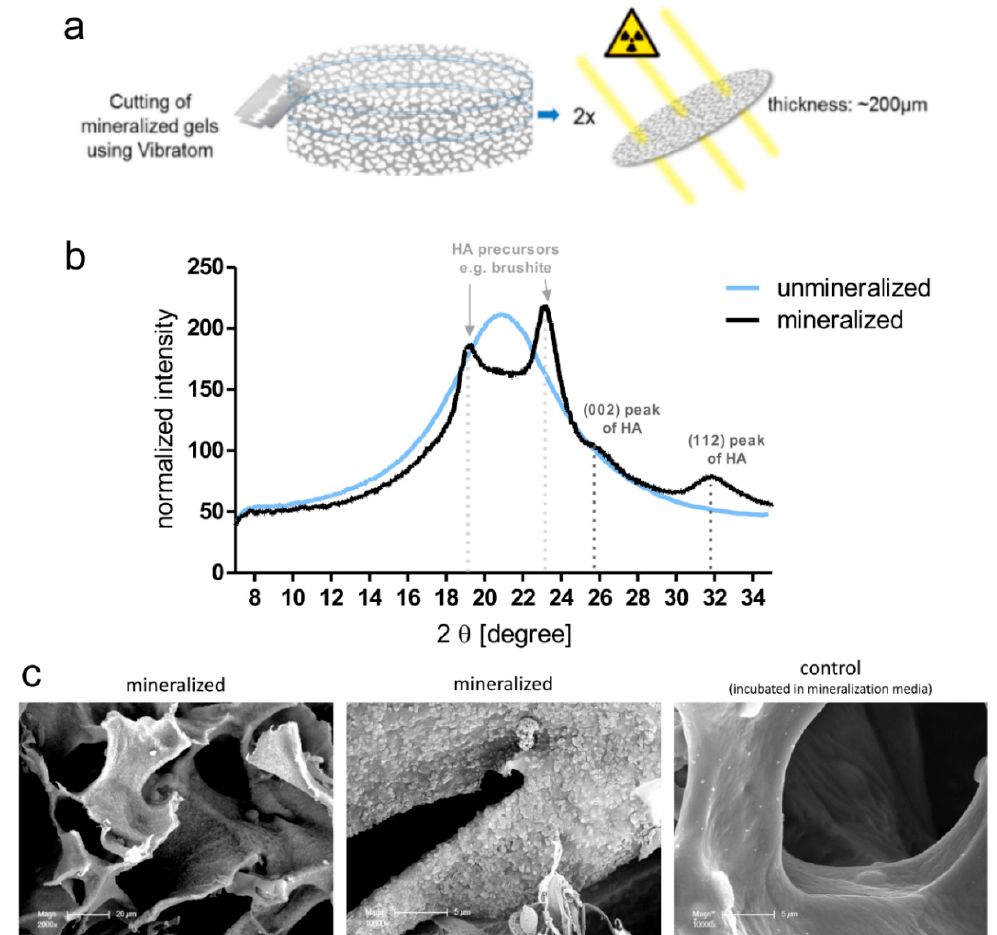
Figure 2. Wide-Angle X-ray Scattering (WAXS) diffraction pattern and scanning electron microscopy (SEM) of mineralized in comparison to nonmineralized cryogels. ( a ) Two different cryogel scaffolds were analyzed. Each cryogel scaffold was cut into thin slices (400 µ m swollen state/200 µ m dry state) using a vibratome. Afterwards the cut gel discs were dried and then analyzed in their mineral structure with WAXS technique using a NANOSTAR instrument (Bruker, Berlin, Germany). Diffraction patterns of each gel discs were recorded at three different spots within the cryogel discs, one in the middle and two points at the border of the discs, to check if the cryogels were equally mineralized throughout the whole scaffold. ( b ) Diffraction pattern of unmineralized cryogel were found to have one broad peak. This peak probably results from the polymer matrix of the cryogel scaffolds, which when dried show a peak that is characteristic for amorphous polymer materials. Mineralized scaffolds were found to have peaks at four different positions. According to the literature, the principal diffraction peaks of hydroxyapatite (HA) appear at 2 θ values of 25.9 ◦ for reflection (002) and at 31.9 ◦ for (112) reflection. Additional peaks, e.g., at ~23 ◦ , were found, suggesting the presence of other types of calciumphosphate (e.g., brushite, which is often formed as a precursor of HA). Graph shows the average diffraction pattern of two samples. Per sample, diffraction patterns at three different positions were recorded. ( c ) SEM images demonstrate mineralized (left and center) versus nonmineralized (right) cell-free cryogel scaffolds. Scale bars = 20 µ m, 5 µ m and 5 µ m, respectively. 2.3. The 3D–2D In Vitro Model Provides a Method for the Analysis of Paracrine Effects between Breast-Cancer Cells and hOBs